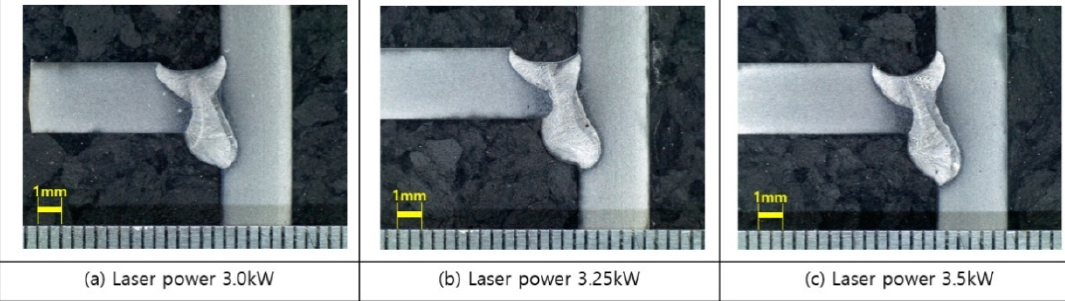
Figure 13. Applying di ff erent levels of laser power with 1.0 mm beam location. Table 10. Welding conditions of Step 3 (wire feeding speed change, beam location change, 12 cases).